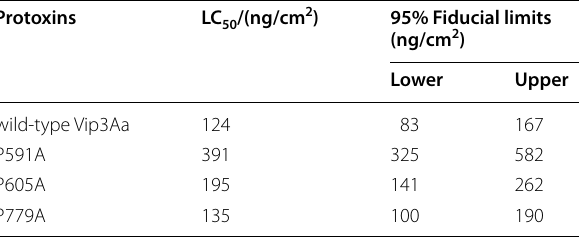
Table 1 Insecticidal activity of wild‑type and mutant Vip3Aa against S.